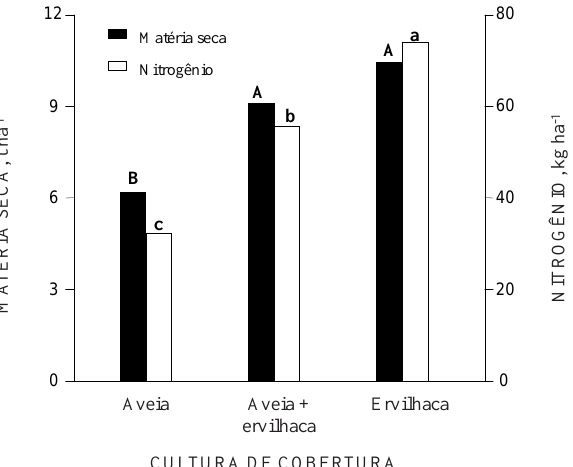
Figura 6. Produção de matéria seca e quantidade de nitrogênio absorvido pelo milho aos 95 DAE com cultura de cobertura antecedente considerando três sistemas de cultura, média de três sistemas de preparo. Letras maiúsculas comparam produção de matéria seca e letras minúsculas comparam quantidade de nitrogênio pelo teste de Duncan a 5%.